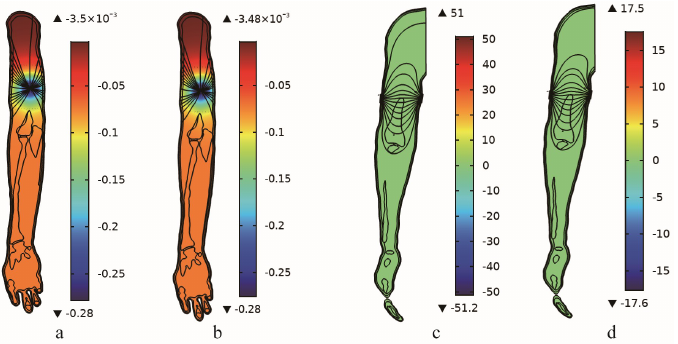
Figure 3. Electric potential distribution diagram of the axial section. ( a , b ) Side view sections. ( c , d ) Front view sections. ( a , c ) Coupling electric potential distribution on the DC electric stimulation section. ( b , d ) Coupling electric potential distribution on the AC electric stimulation